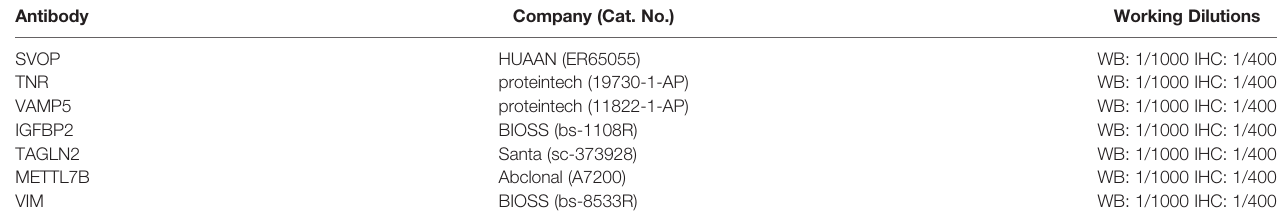
TABLE 2 | Primary antibodies used for western blot and immunohistochemistry. Antibody Company (Cat.